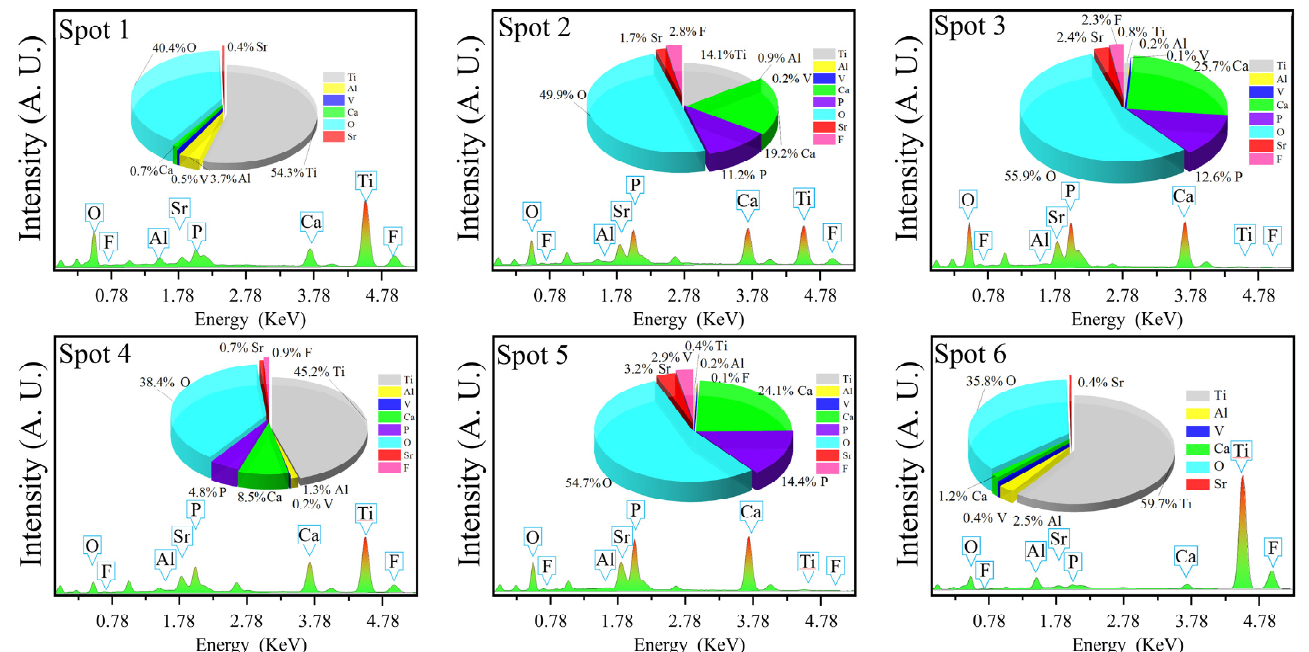
Figure 8. EDS analyses of the calcination products (C30 − C70).